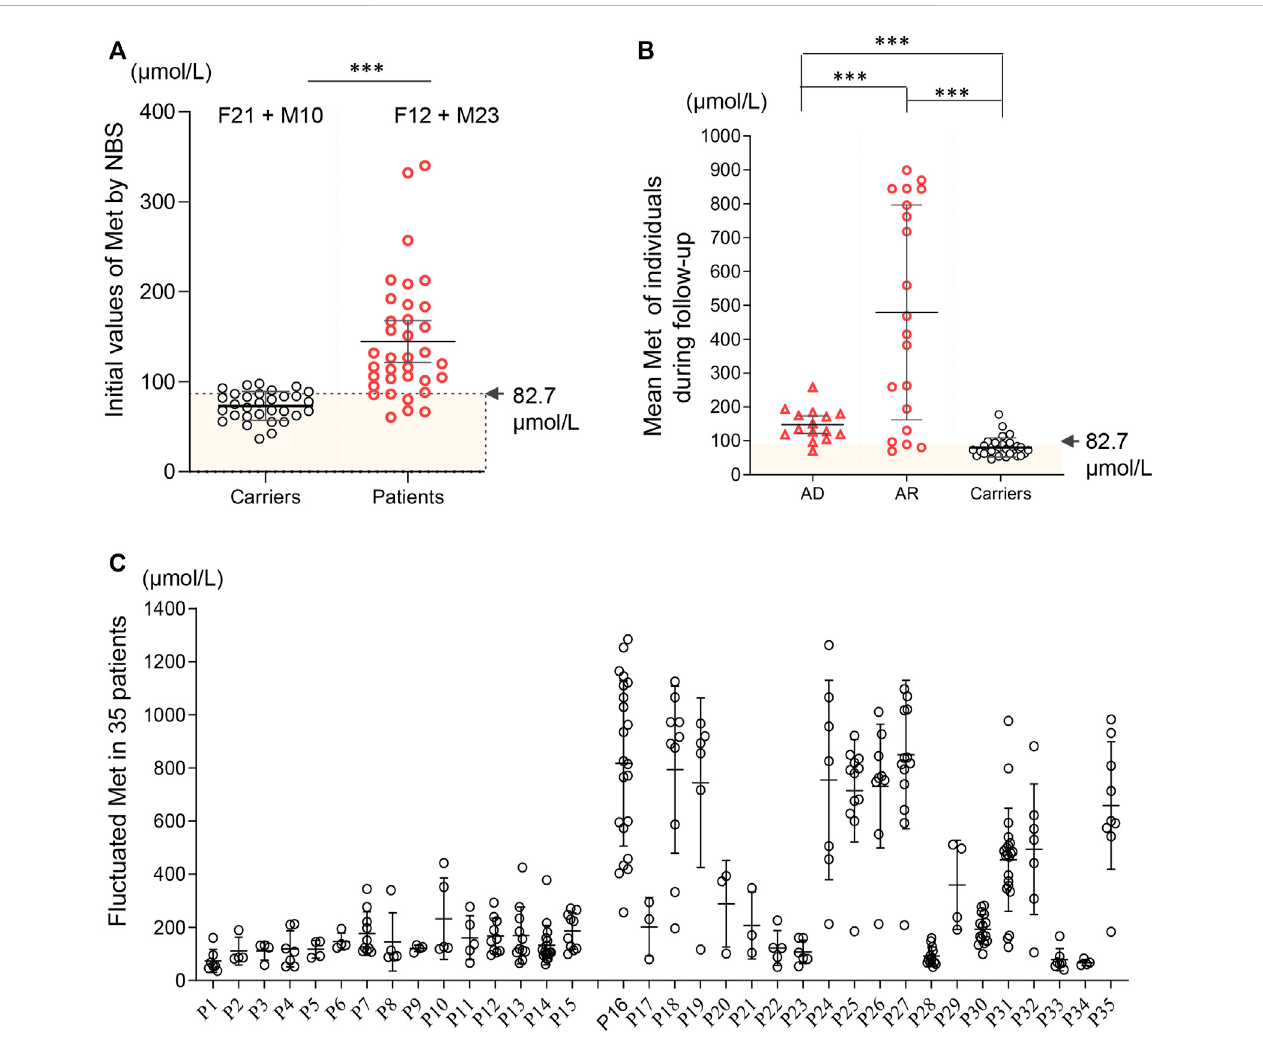
FIGURE 1 Methioninevalues basedonnewborn screeningandfollow-upamong35patientsand31carriers. (A) InitialMetvalues bynewbornscreeningdistributed incarriers(black)andpatients(red).Signi fi cantdifferencewasfoundinthemeaninitialMetvaluesbetweencarriers(73 μ mol/L)andpatients(145 μ mol/L).F12 + M10= 12 femalesand 10males. 4asymptomatic patients (AD-P11; AR-P17, P33, P34) had initial Met < 82.7 μ mol/L. (B) Mean plasma Metduring follow-up in patients (AD, AR) and carriers. Asymptomatic patients P1, P33 and P34 had a mean Met below 82.7 μ mol/L. (C) Fluctuated plasma Met values (including minimum, maximum and mean value of Met) during follow-up among each 35 individuals. *, p < .05; **, p < .01; ***, p <